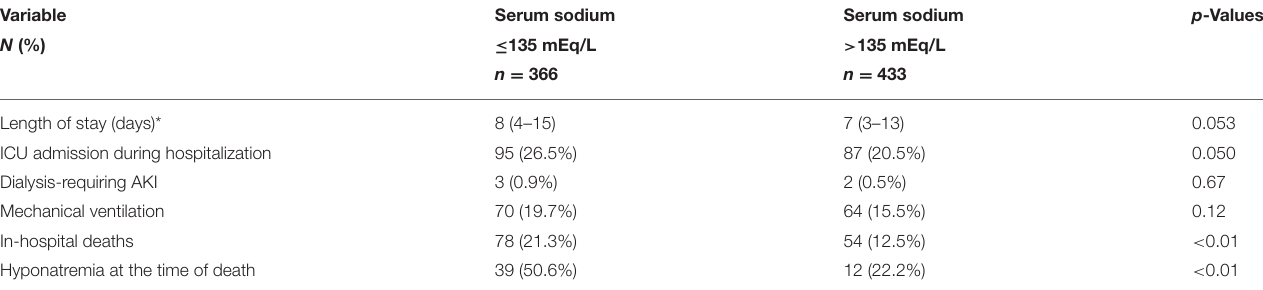
TABLE 3 | Clinical Outcomes in hospitalized patients with COVID-19 with and without hyponatremia on admission.